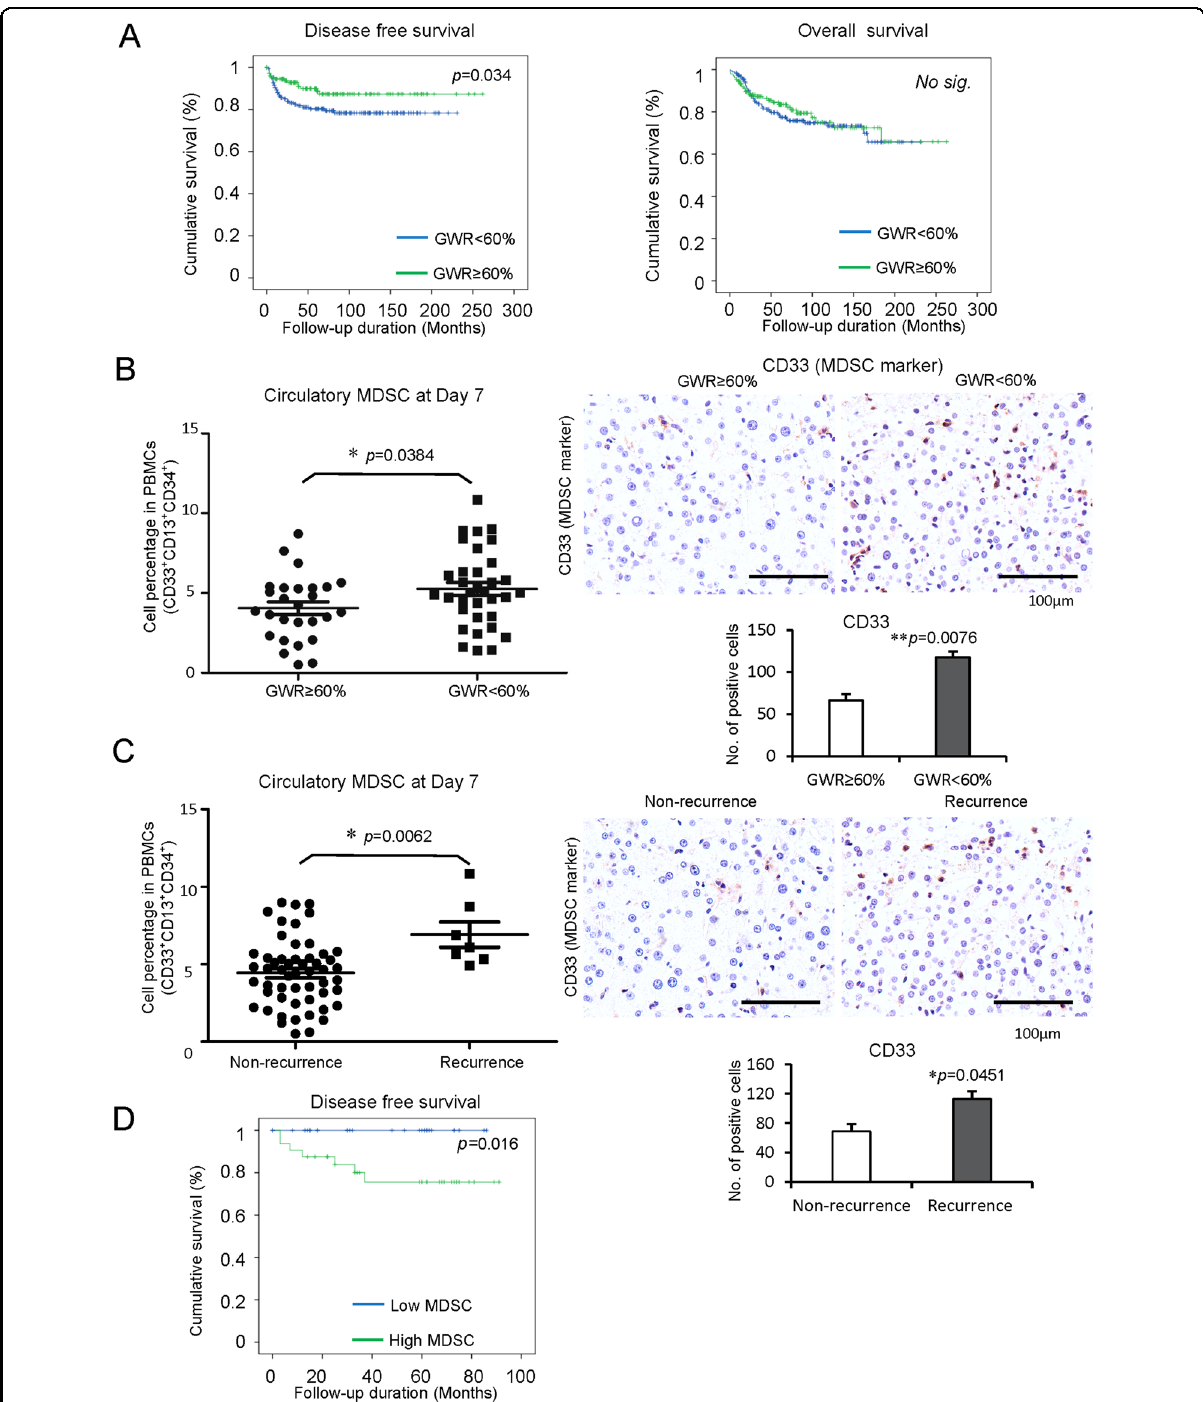
Fig. 1 Increased MDSCs in HCC patients with small-for-size graft or tumor recurrence accompanied by poor disease-free survival post- transplantation. The circulatory and intragraft MDSCs were detected on Day 7 and hour 2 after liver transplantation, respectively. A The patients who received small-for-size liver grafts (GWR< 60%) had poor disease-free survival than patients with large liver grafts (GWR ≥ 60%) ( n = 331). B Increased circulatory and intragraft MDSCs in patients with small-for-size grafts compared to those with large liver grafts ( n = 61). C More circulatory and intragraft MDSCs in patients experienced HCC recurrence in contrast with non-recurrent patients ( n = 61). D Poor disease-free survival in HCC patients with high MDSCs post-transplantation ( n = 61). Scale bars: 100 μ m. Error bars indicate standard error of mean; *p < 0.05, ** p < 0.01. MDSC myeloid- derived suppressor cell, HCC hepatocellular carcinoma, GWR graft weight